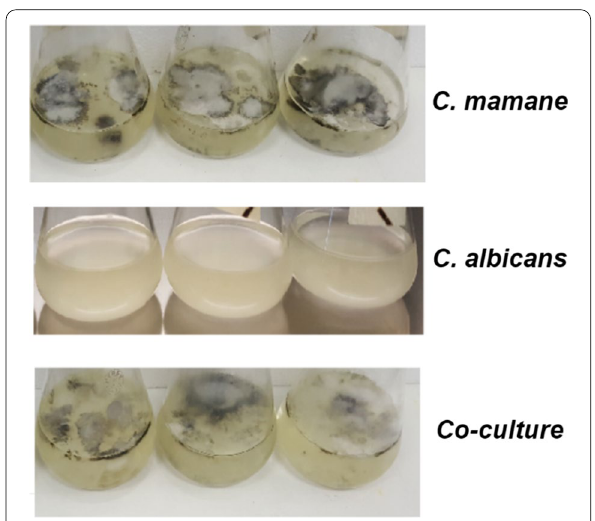
Fig. 1 Morphological differences among cultures in PDB